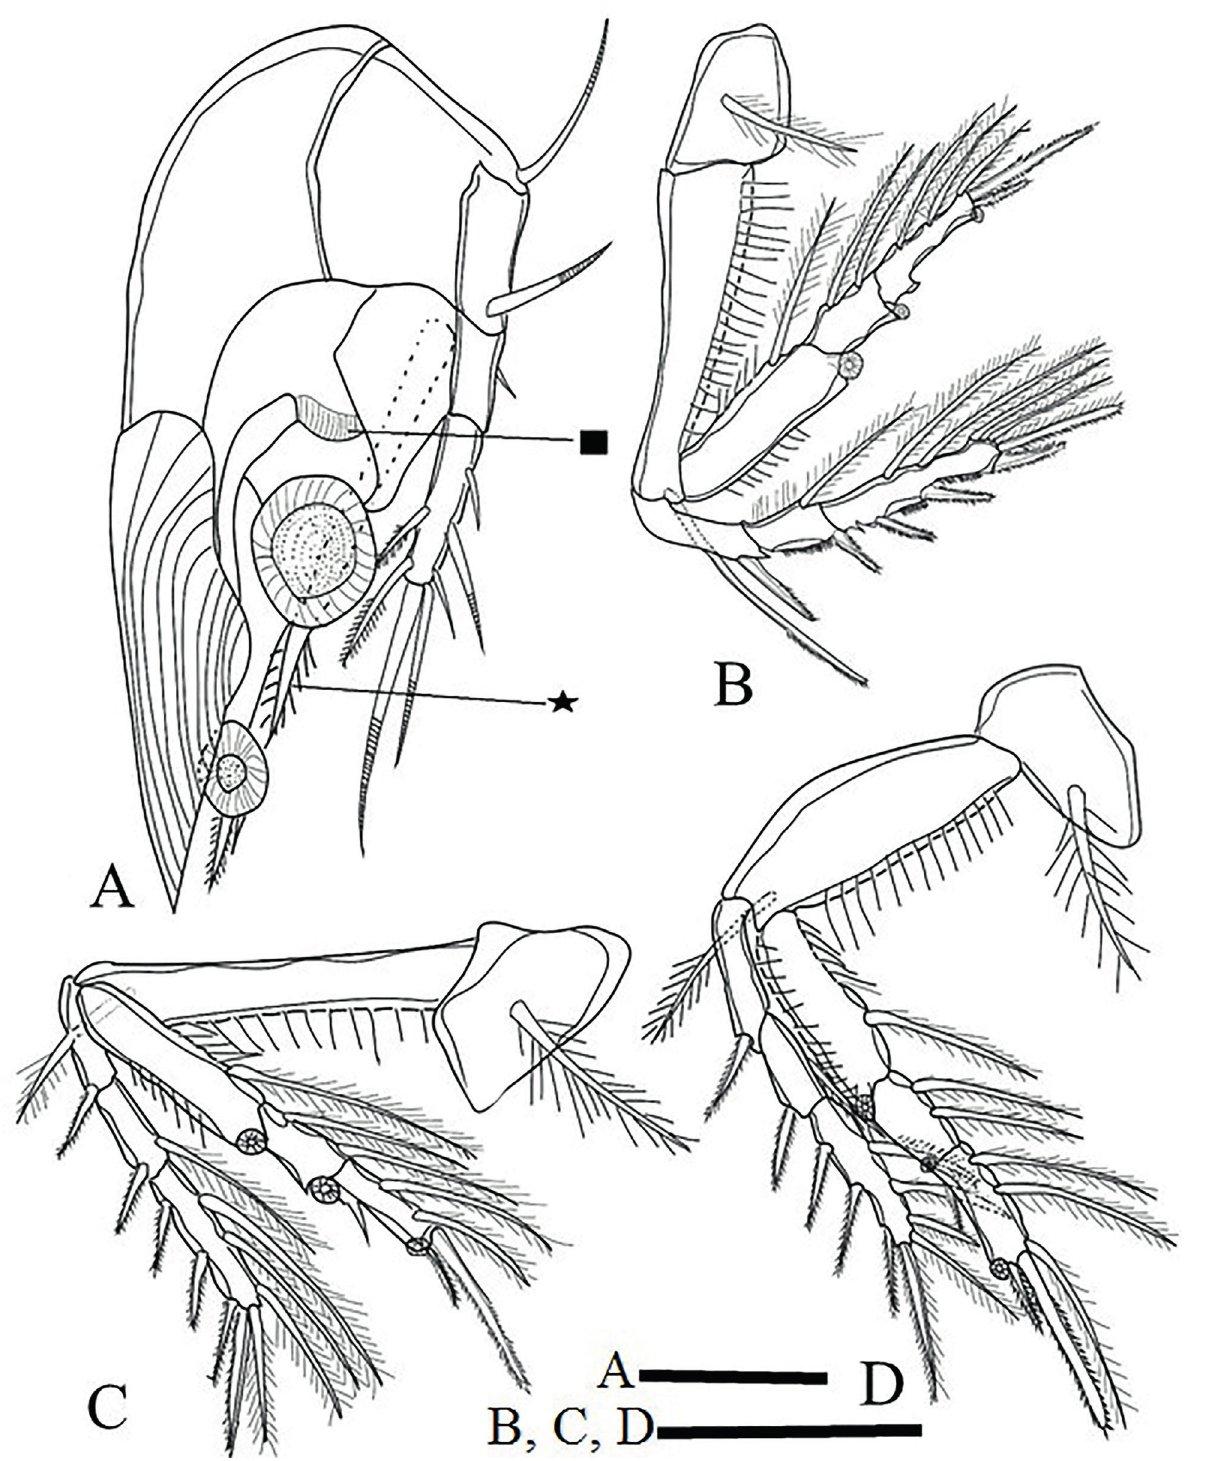
Figure 4. Clausidium persiaensis sp. nov. (female). A, P1; B, P2; C, P3; D, P4. Square = adhesive fringe; asterisk = long seta of endopod 2. Scale bars: A, 100 μm ; B, 50